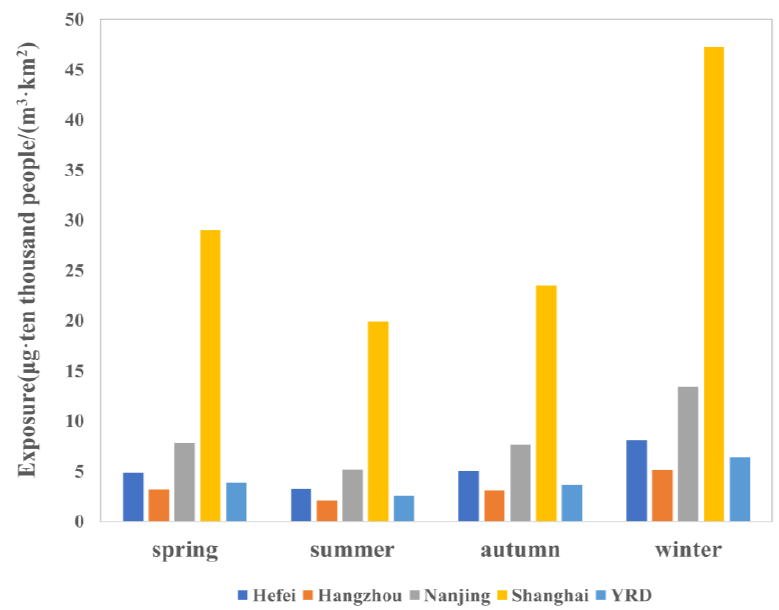
Figure 6. Intensity of population exposure to PM 2.5 in the major cities during the four seasons of 2013 in the YRD Region.